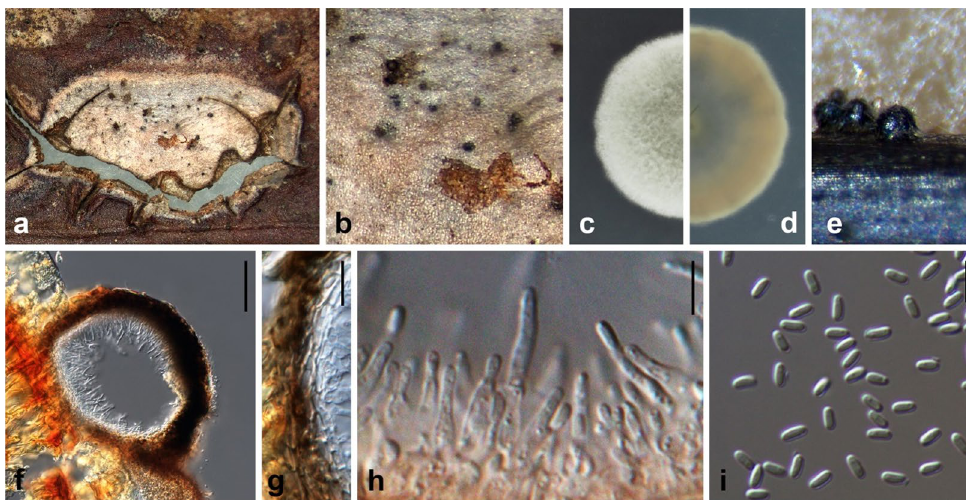
Figure 9. Amorocoelophoma camelliae (NTUH 18-097-1, holotype ). ( a ) Leaf lesions. ( b ) Appearance of conidiomata on host surface. ( c , d ) Cultures on PDA, from above and below. ( e ) Pycnidia on pine needle. ( f ) Vertical section of conidioma. ( g ) Conidiomatal wall. ( h ) Conidiogenous cells and developing conidia. ( i ) Conidia. Scale bars: ( f ) = 50 μm, ( g ) = 10 μm, ( h , i ) = 5